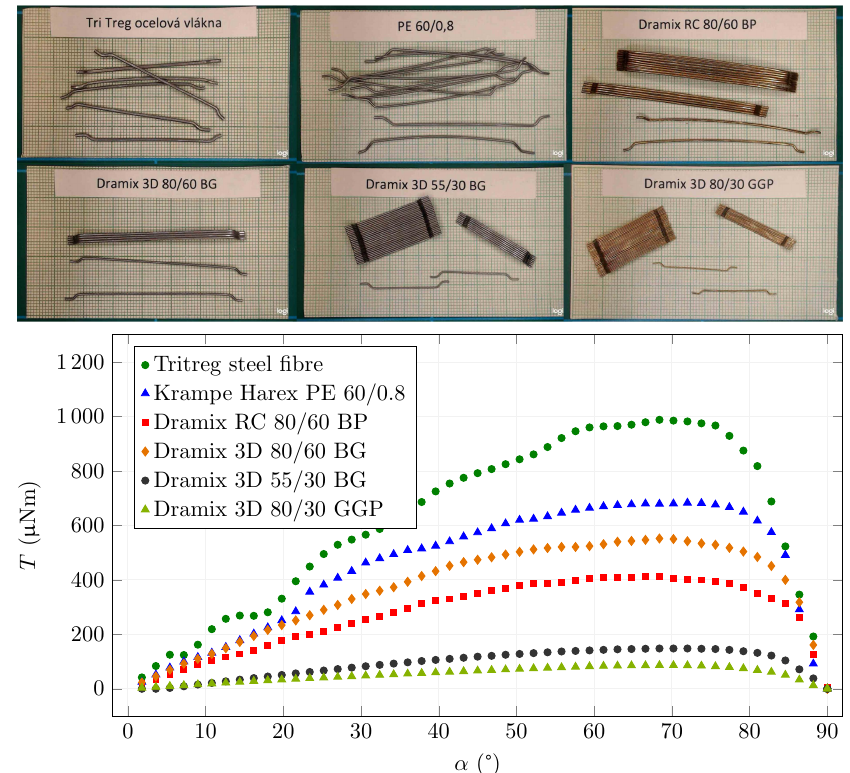
Figure 11. Torque and fibre angle relationship for different types of hook-end fibres.